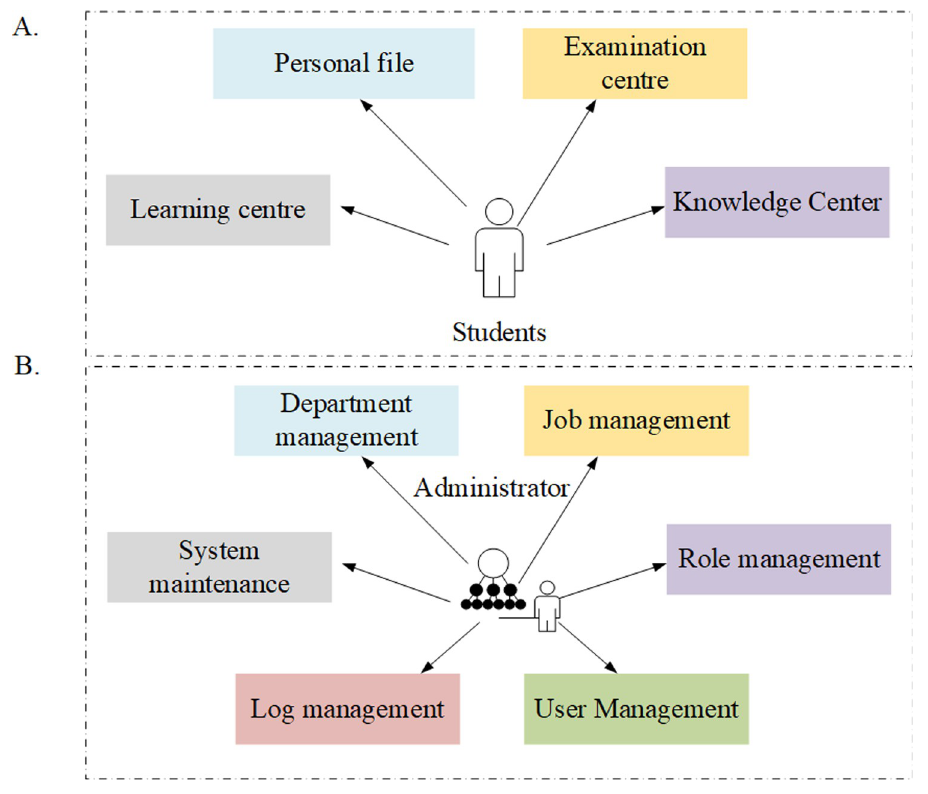
Fig 4. Analysis of students and system management